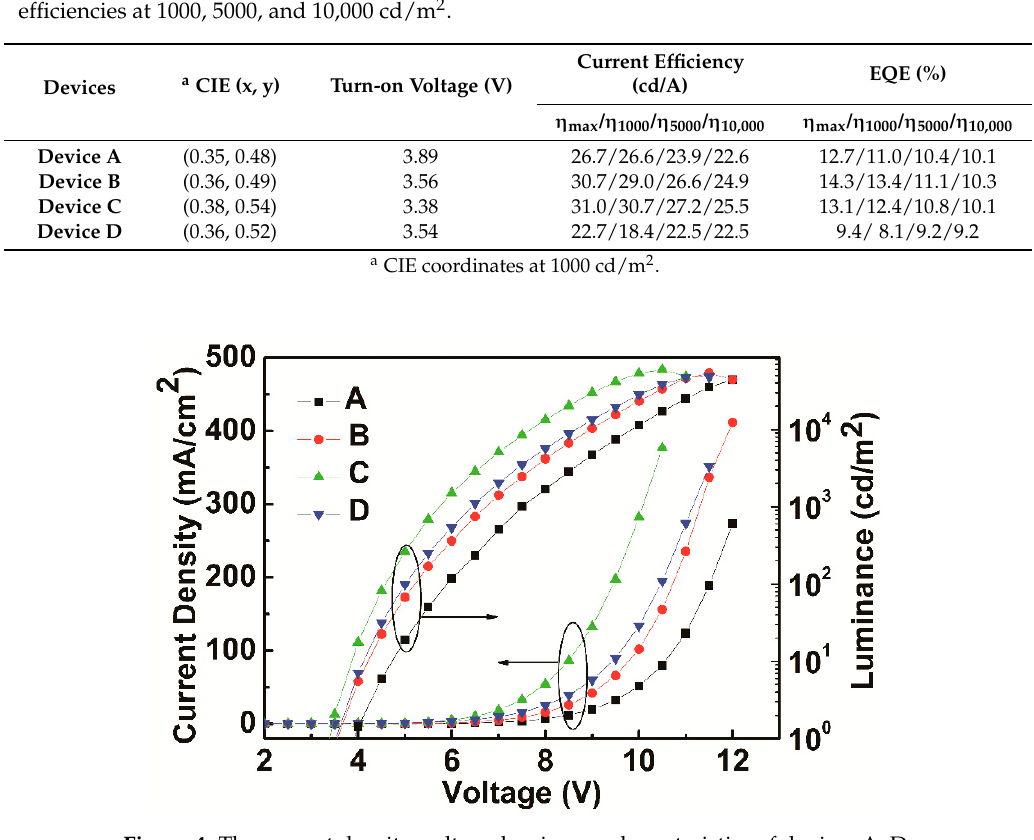
Table 1. Performance characteristics of devices A–D. Ƞ max : Maximum ef fi ciency, Ƞ 1000 , Ƞ 5000 , Ƞ 10,000 : ef fi ciencies at 1000, 5000, and 10,000 cd/m 2 .